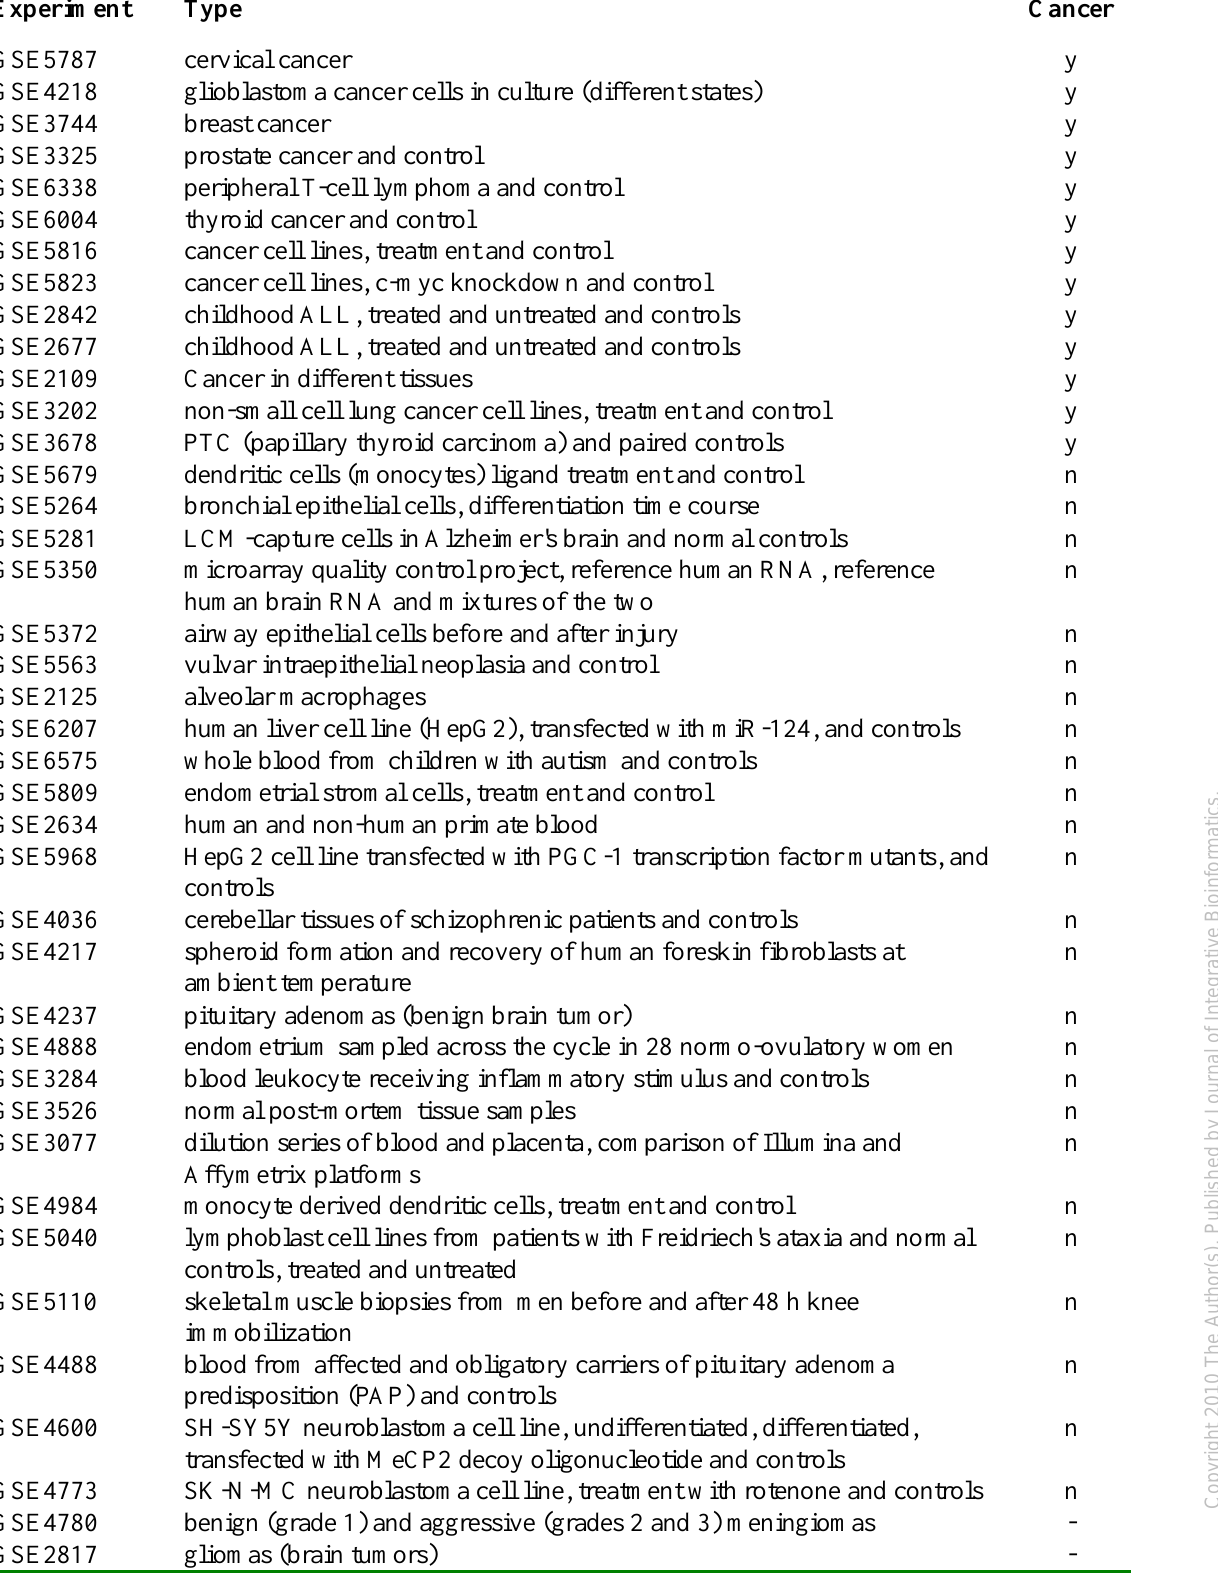
Table 2. Description of the GSE experiments